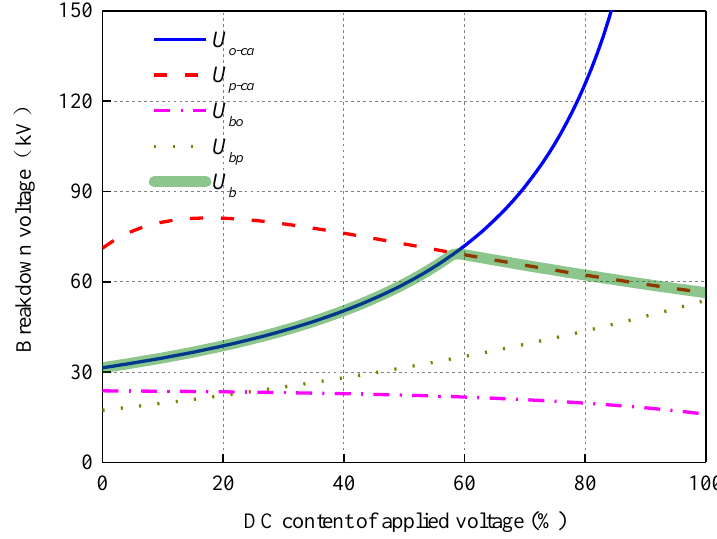
Figure 12. Calculation of the breakdown voltage of oil-pressboard insulation under different DC contents.